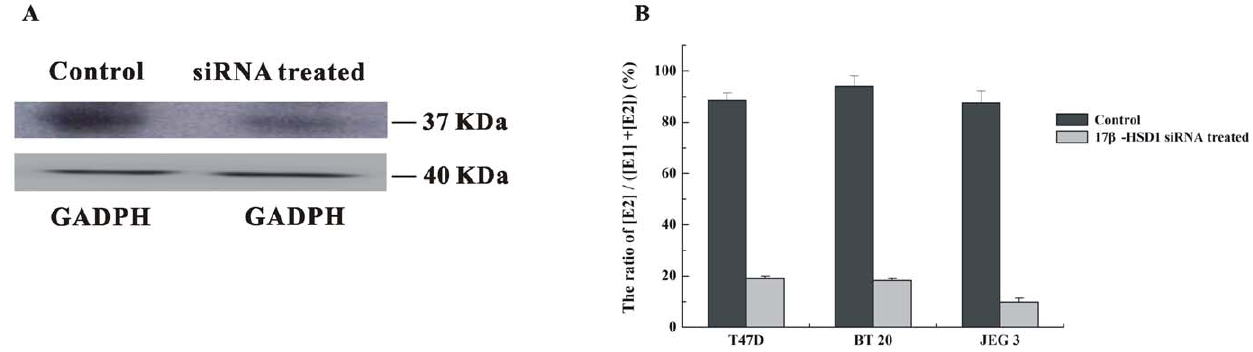
Figure 3. The conversion from E1 to E2 in T47D, BT 20 and JEG 3 cells after knocking down 17 b -HSD1. A. 17 b -HSD1 expression levels after being treated with specific siRNAs and control siRNAs (mixed SNC1 siRNA and scramble siRNA) in T47D cells. 200,000 cells were seeded onto 6- well plates, the cells were transfected with 100 nM mixed specific siRNAs for 17 b -HSD1 or control siRNAs for 48 hours, then western blot was carried out. GADPH was chosen as the internal control protein. B. The conversion from E1 to E2 in T47D, BT 20 and JEG 3 cells after being treated with 17 b - HSD1 specific siRNAs.